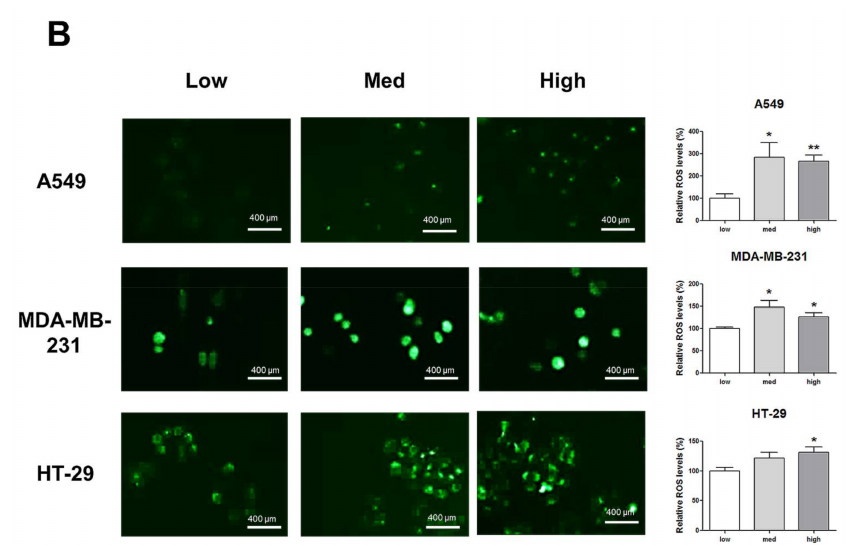
Figure 2. Increased pericellular hypoxia and ROS levels according to the increase in cell density. ( A ) Western blot data demonstrate that HIF-1 α expression, which was considered to be induced by pericellular hypoxia in our experiments, was significantly higher in high-density than in low-density in A549 and MDA-MB-231 cells, whereas HIF-1 α expression was not increased in high-density compared with that in low-density in HT-29 cells. ( B ) Representative images show increased ROS signals (green) according to the increase in cell density. The graphs show the quantitative analysis of the ROS data. ROS levels were significantly increased with an increase in cell density in A549 and MDA-MB-231 cells, whereas ROS levels in HT-29 cells were significantly increased only when the cells were cultured at a high density. All experiments were performed in triplicate, and the data represent the mean ± standard error. * p < 0.05 and ** p < 0.01 versus the low-density